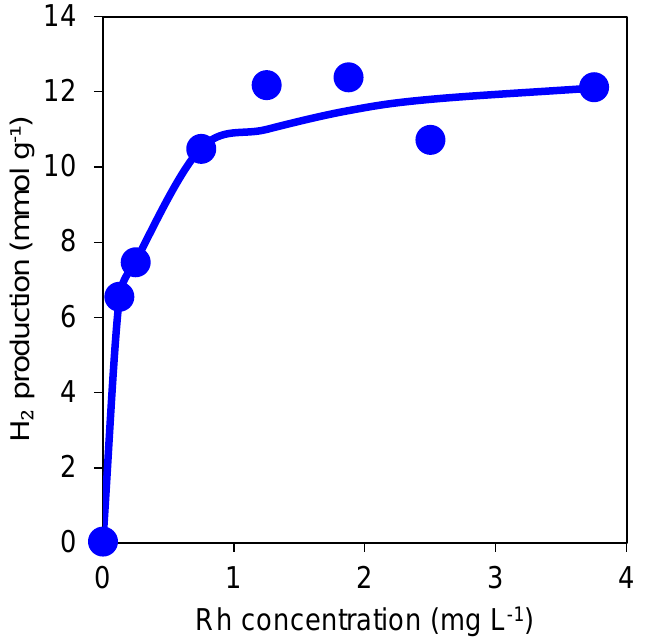
Figure 1. Effect of Rh 3+ ion concentration. TiO 2 , 50 mg; reaction time, 3 h; reaction temperature, 50 °C; formic acid concentration, 1 wt%.